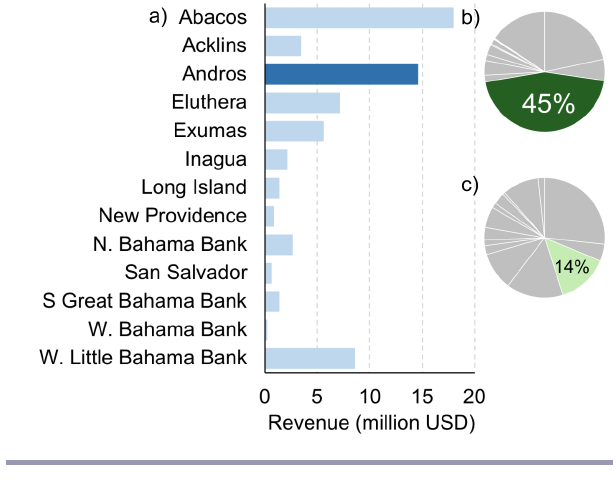
Bahamas (gray portion of pie charts).